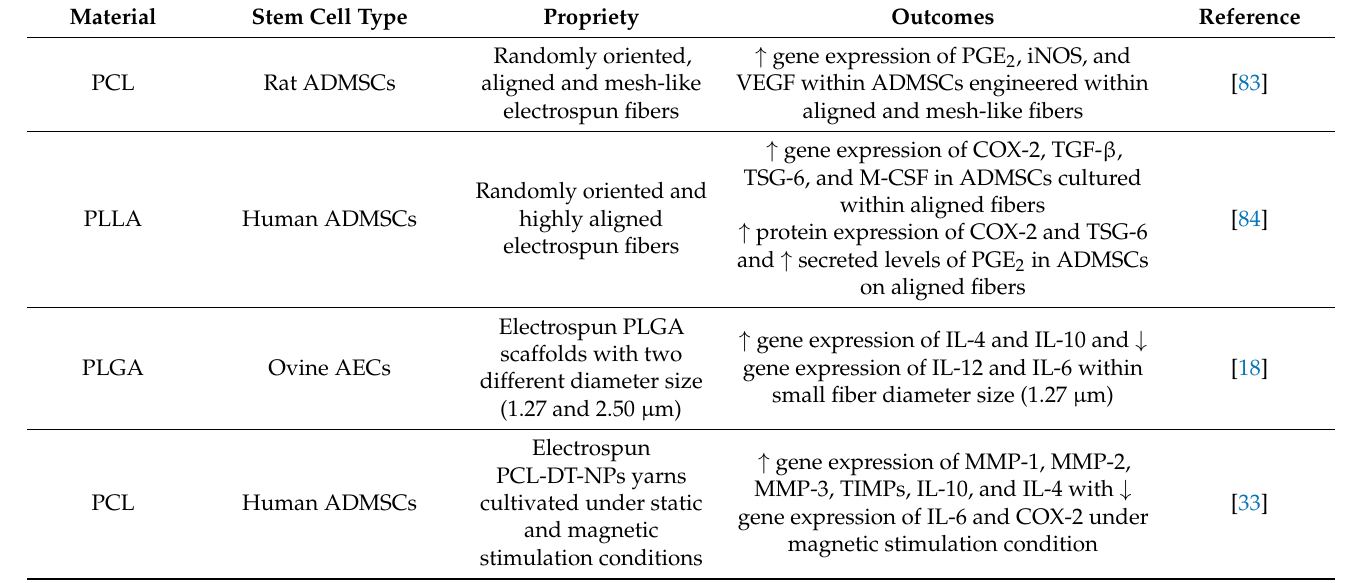
Table 2. Overview of the influence of different electrospun scaffolds properties on the immunomodu- latory properties of stem